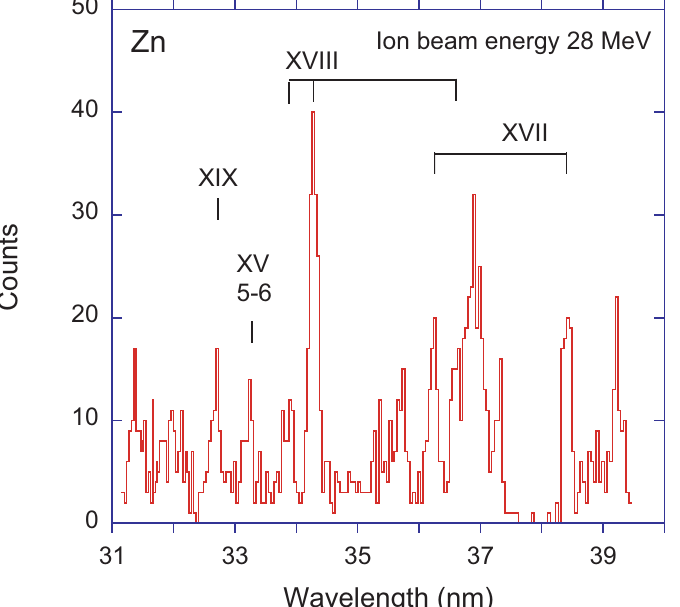
Figure 27. Beam-foil spectrum of Zn at an ion beam energy of 28MeV. Observation at a position near the foil (delay about 100ps), line width (FWHM) 0.15nm; The strongest lines arise from intercombination transitions in Mg-, Al- and Si-like ions of Zn. The lines are identified by the spectrum